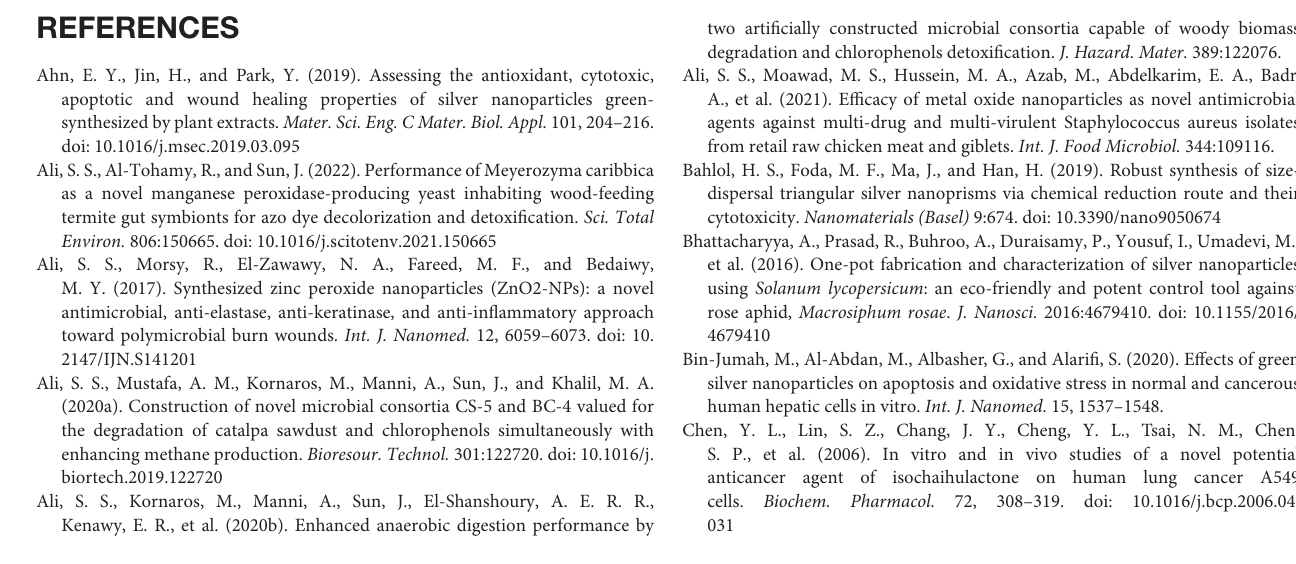
Supplementary Figure 1 | Agar well diffusion technique on MHA plates showing antibacterial activity of Bio-AgNPs against selected isolates (A) S. aureus and